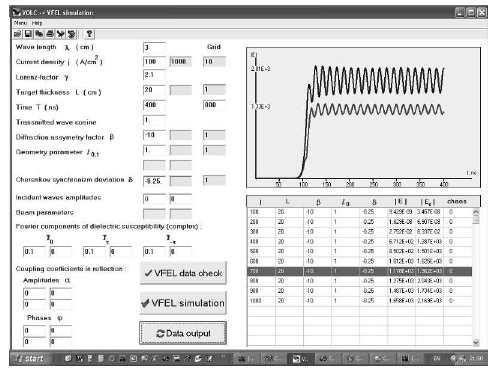
Figure 1. Interface of computer code